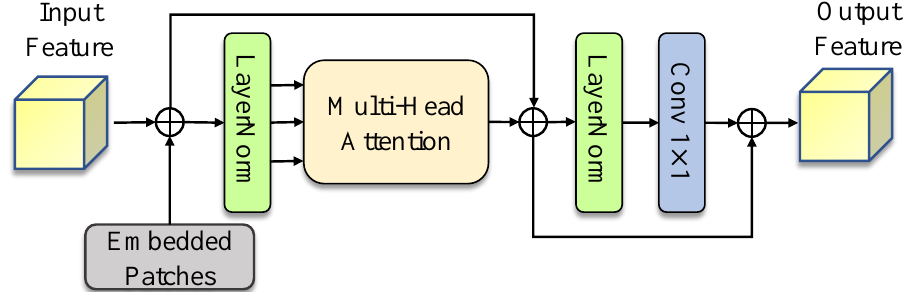
Figure 4. The inner structure of the transformer